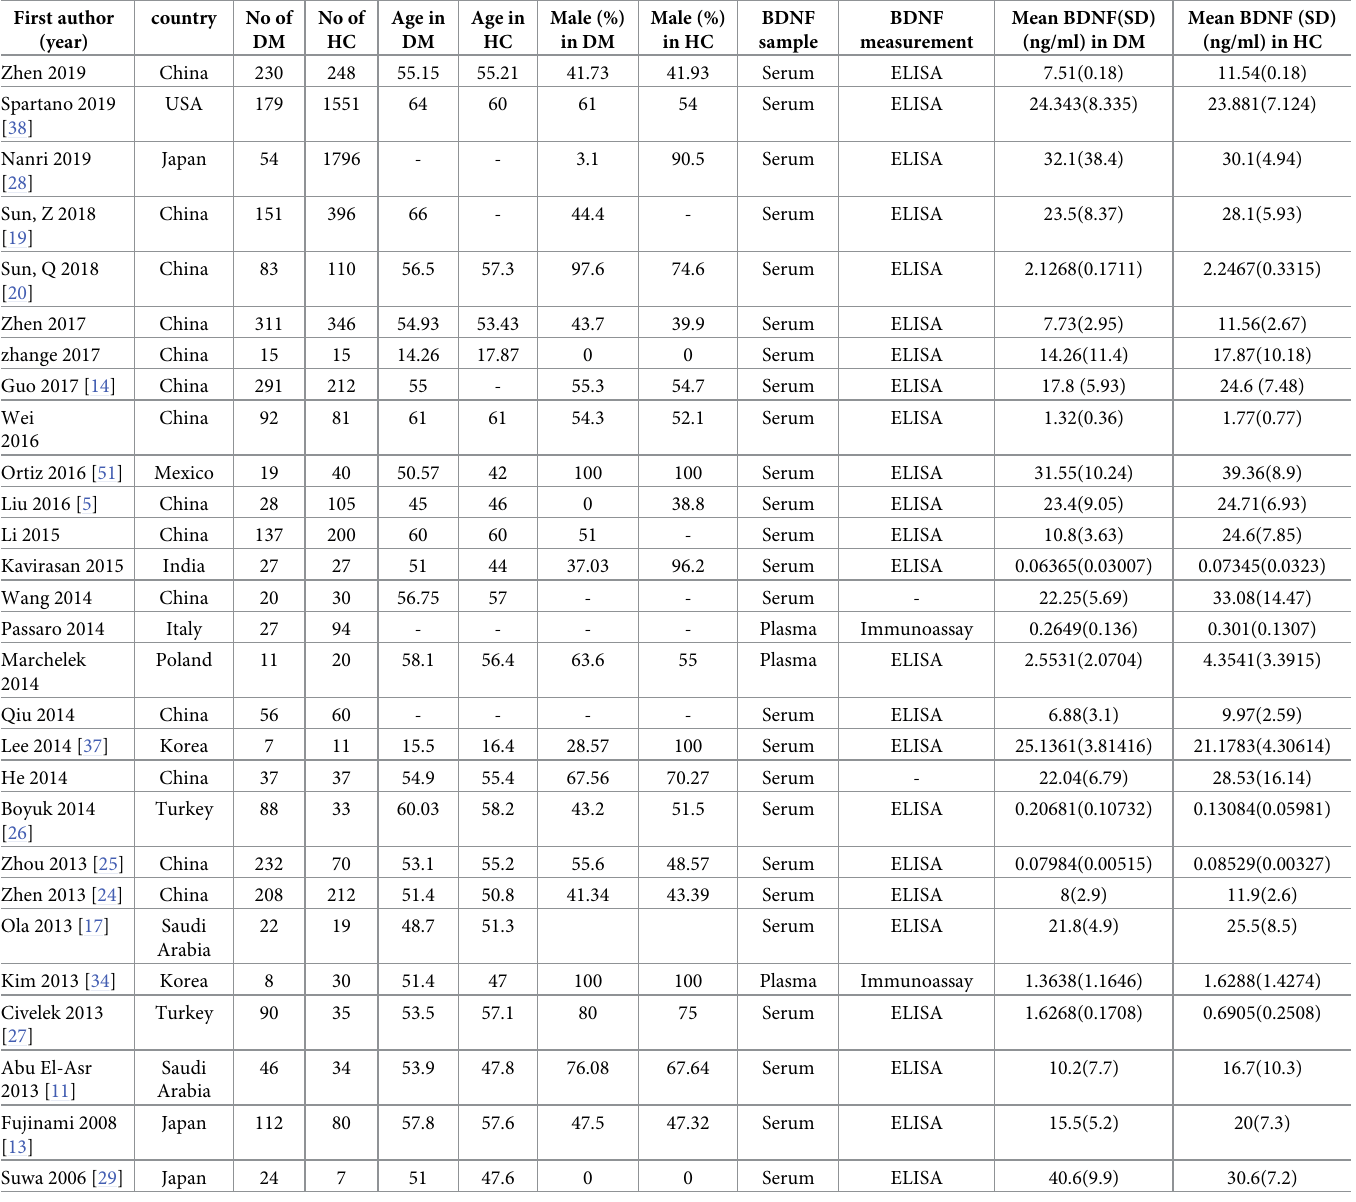
Table 1. Characteristics of the included